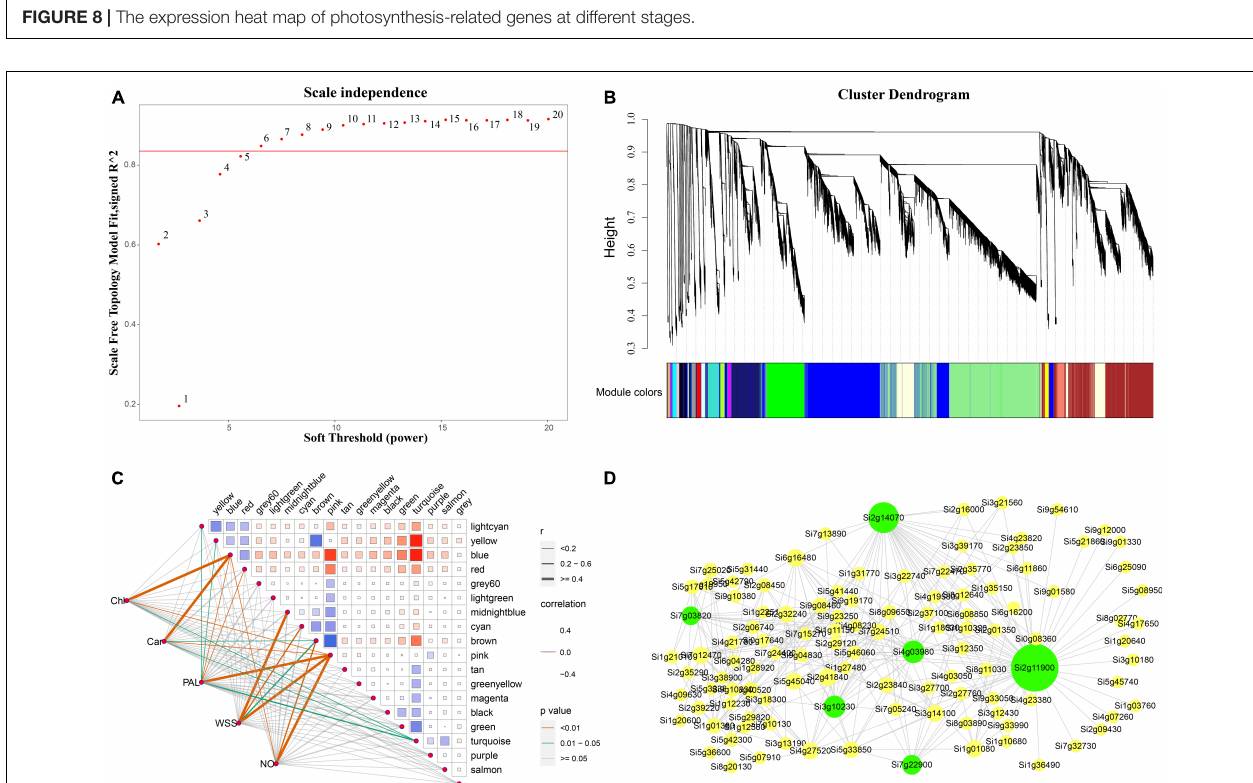
FIGURE 9 | Co-expression networks of chlorophyll related genes based on Weighted Gene Co-expression Network Analysis (WGCNA). (A) Scale-free network model index under different soft thresholds, the abscissa represents the soft threshold, and the red line represents the optimal soft threshold; (B) gene clustering tree based on the topological dissimilarity matrix, and different colors represent different modules; (C) heat map of correlation between modules and traits, the abscissa and ordinate represent different modules, and the left part represents the sample traits; (D) correlation between modules and traits was analyzed and gene co-expression networks in the chlorophyll content-related gene module. Green in the Figure represents the core gene.